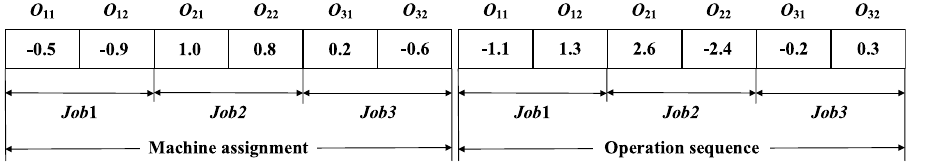
Figure 2. Individual sparrow position encoding scheme.